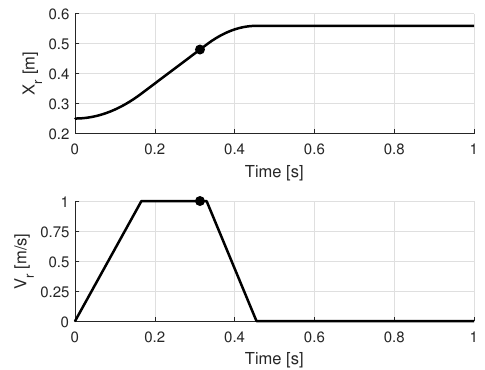
Figure 11. Position and velocity profiles imposed on the tool by the robot control system. The circular dot indicates the impact